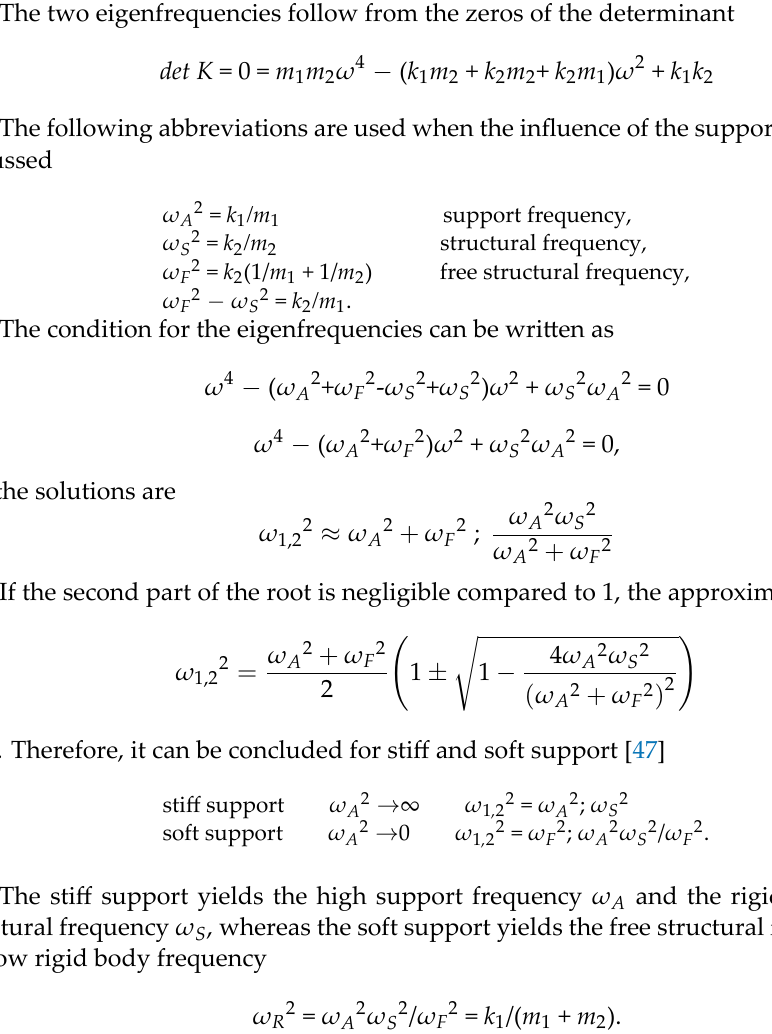
Figure A2. The two‑mass Figure A2. The two-mass system.